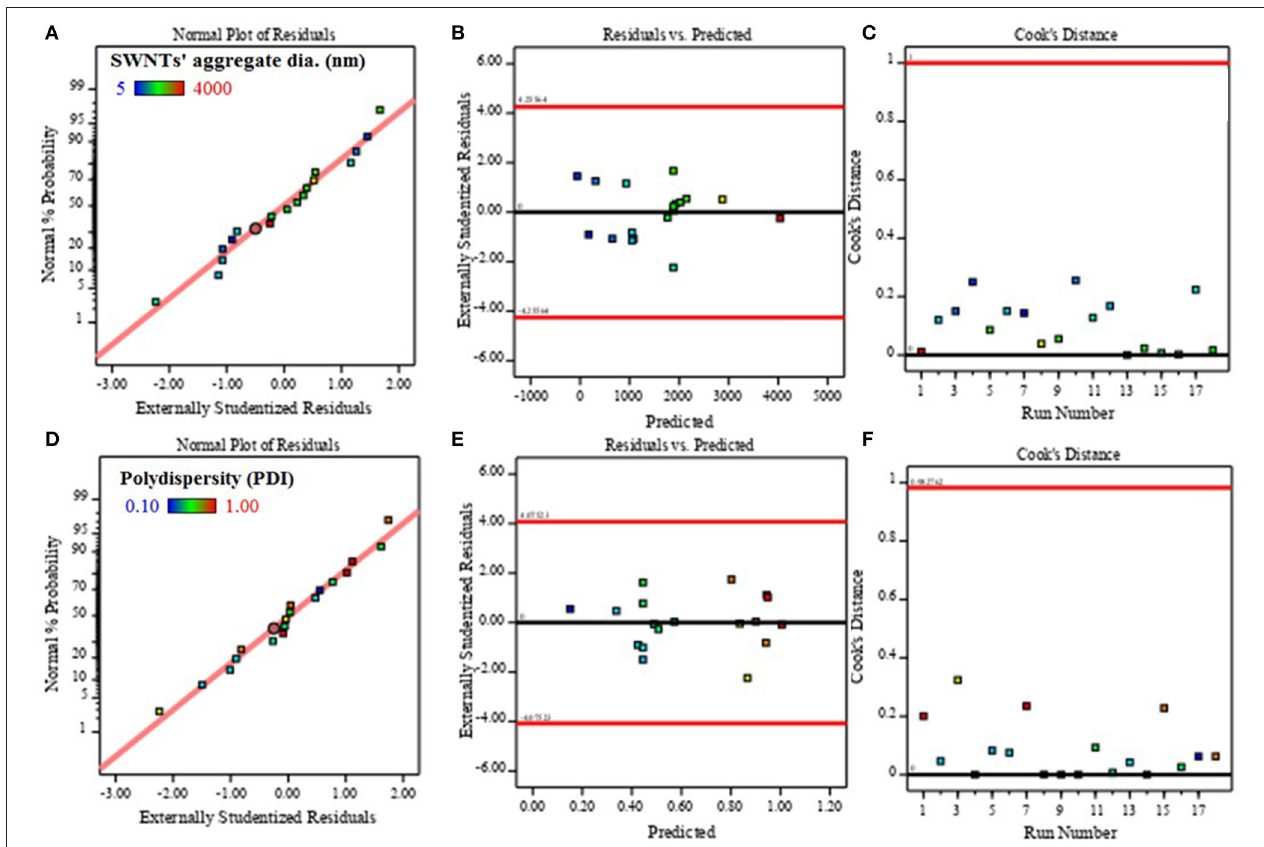
FIGURE 3 | The (A) normal distribution of residuals, (B) absence of pattern in residuals vs. predicted response, and (C) non-existence of outliers in cook’s distance plots for SWNTs’ aggregate diameter and (D,E,F) polydispersity.